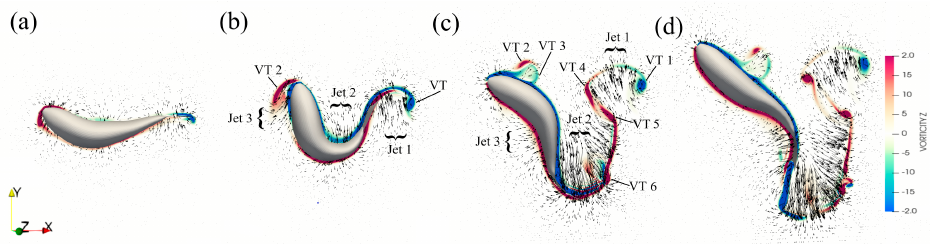
Figure 7. Four snapshots of the flow in the mid-plane visualized by velocity vectors and vorticity ω Z . ( a ) t/T = 0.17. ( b ) t/T = 0.43, the moment of the end of stage 1. ( c ) t/T = 0.76, the moment of the end of stage 2. ( d ) t/T = 1, the last moment of the fast start.